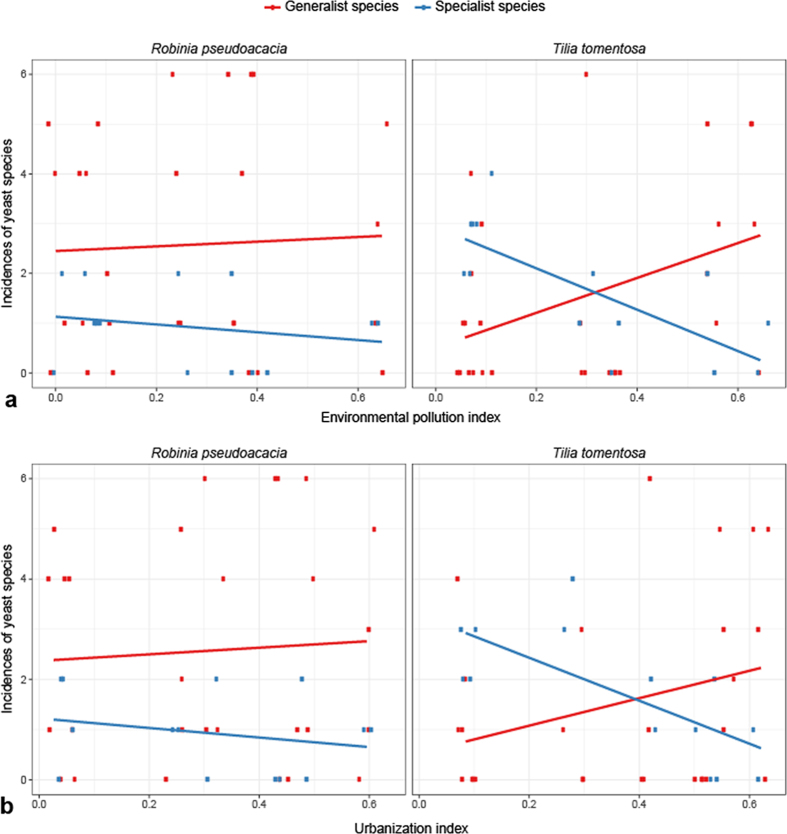
(a) Incidences per sampling site (n = 6 trees per site) of generalist and specialist nectar yeast species according to the calculated pollution index at the radius of 100 m around the particular trees. (b) Incidences per sampling site (n = 6 trees per site) of generalist and specialist nectar yeast species according to the calculated urbanization index at the radius of 100 m around the particular trees.